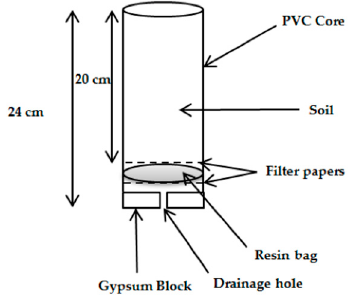
Figure 2. Diagram of the resin core incubation technique [29].